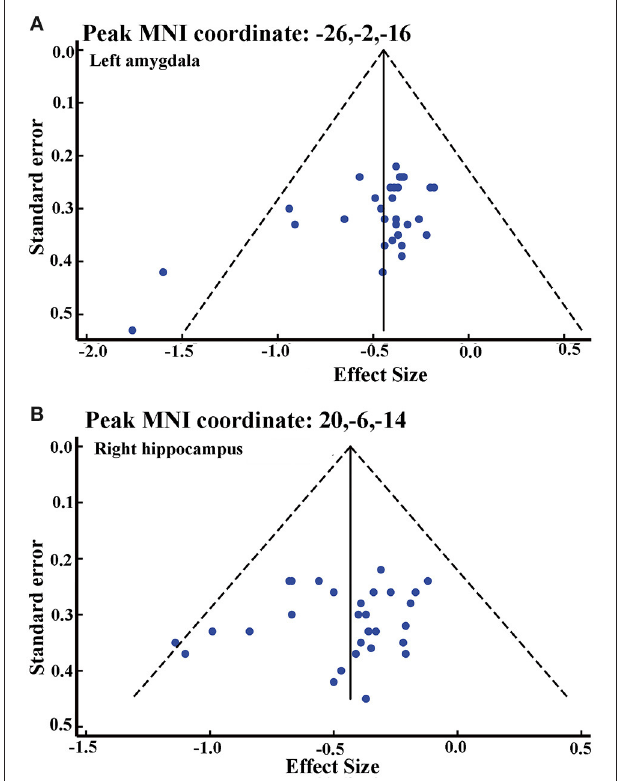
FIGURE 3 | Funnel plot of effect size of left amygdala (A) and right hippocampus (B)